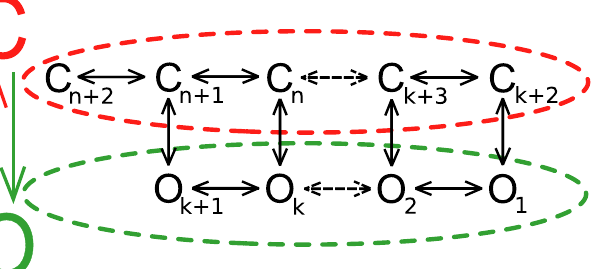
Fig 1. Schematic representation of a general Markovian model of the ion channel gating kinetics [34]. From a simplified point of view the channel can exist in two functionally distinct states: open (O) and closed (C), which are represented by green and red color, respectively. These states can be, in turn, constituted by a discrete number of substates (i.e. (n+2)-(k+2) closed substates C i and (k+1) open substates O j ). The channel’s substates are thought to correspond to its stable conformations. For example, in case of the BK channels, 3-4 open and 5-6 closed substates can represent its kinetics [35]. The possible transitions between channel’s substates are depicted by arrows.